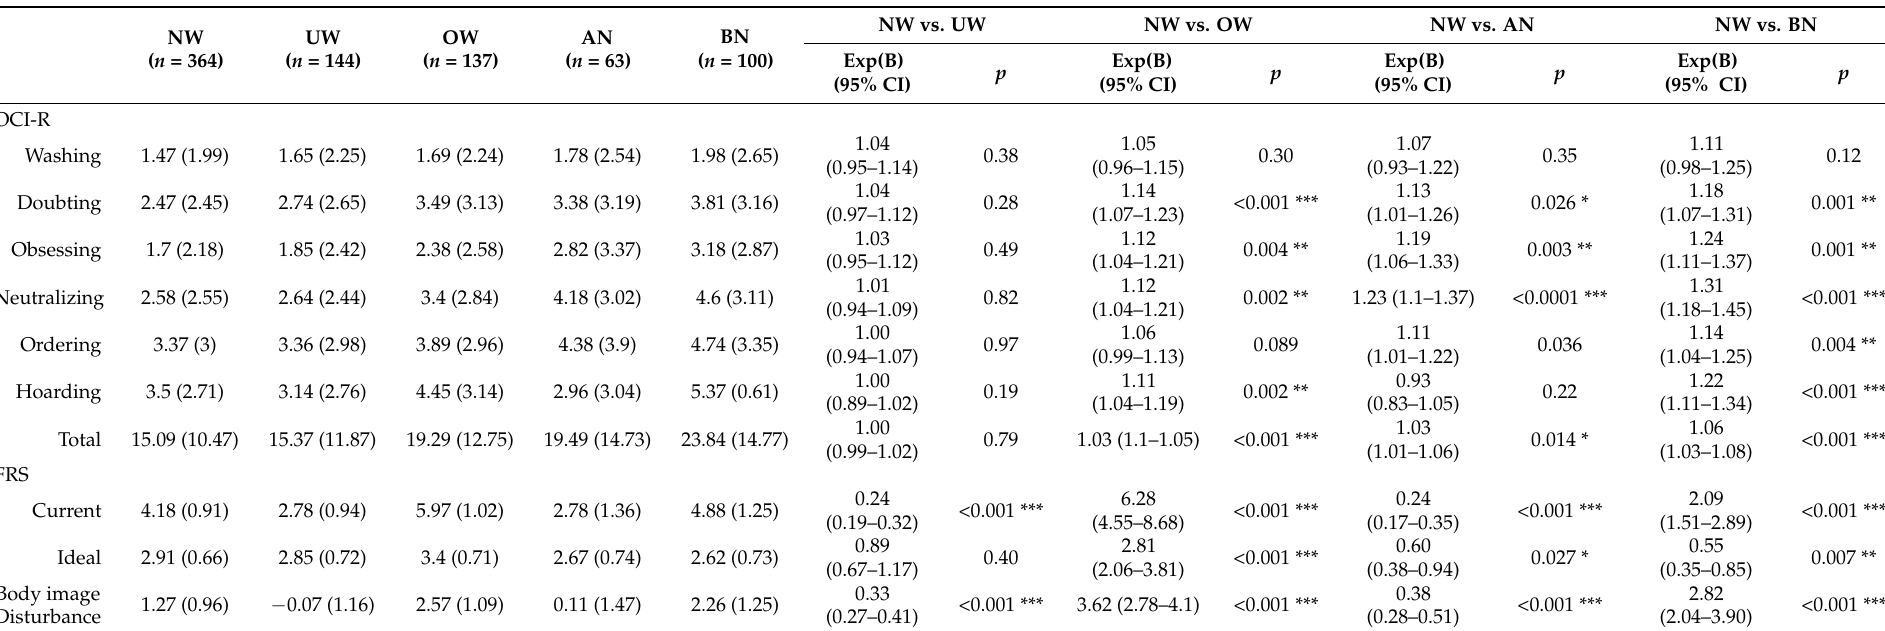
Table 4. Obsessive-compulsive symptoms and body image discrepancy in young women with UW and OW, and patients with AN and BN compared to women with